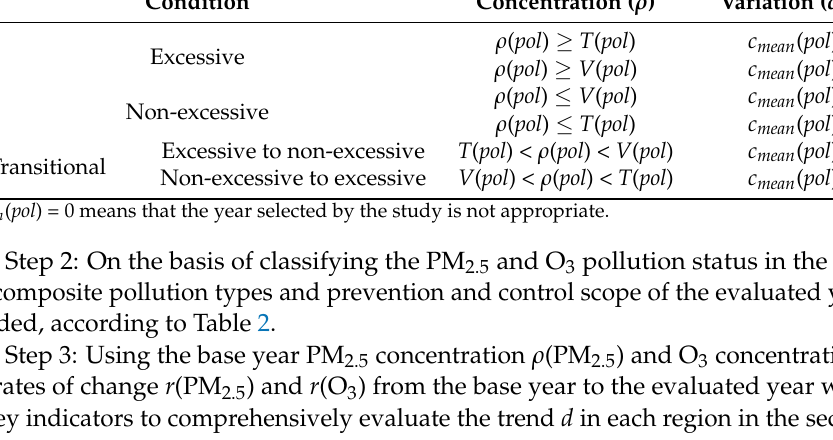
Table 1. Pollutant condition classification according to the threshold and standard values. Condition Concentration ( ρ ) Variation ( c mean ) * ρ ( pol ) ≥ T ( pol ) c mean ( pol ) > 0 Excessive ρ ( pol ) ≥ V ( pol ) c mean ( pol ) < 0 ρ ( pol ) ≤ V ( pol Non-excessive